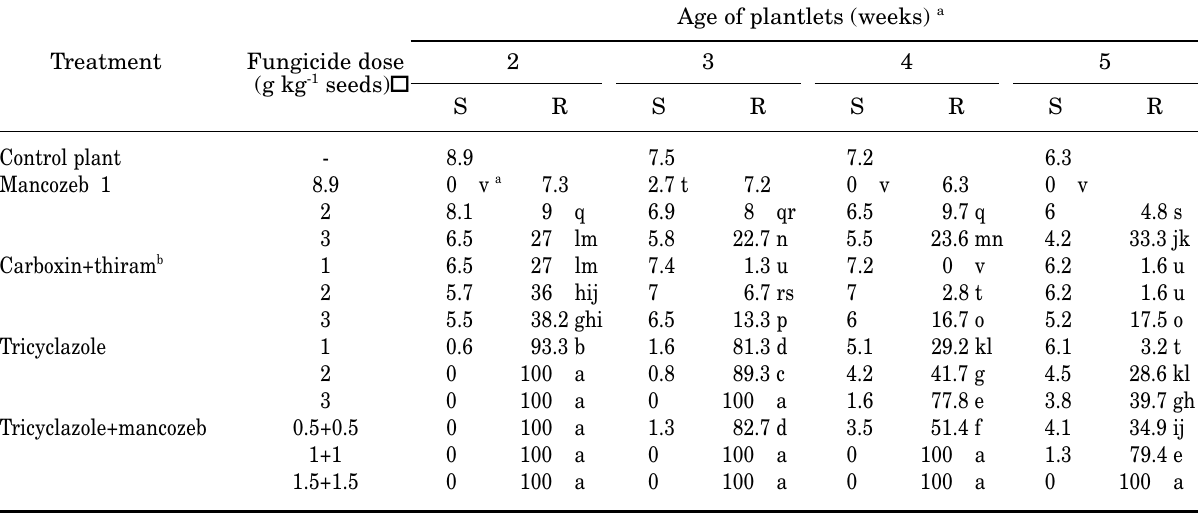
Table 4. Disease severity (S), and percent disease reduction (R), due to fungicides, in rice plantlets infected with Pyricularia grisea. Seeds were treated with fungicides and inoculation was done on two-, three-, four- and five- week-old plantlets. Disease severity was recorded 7 days after